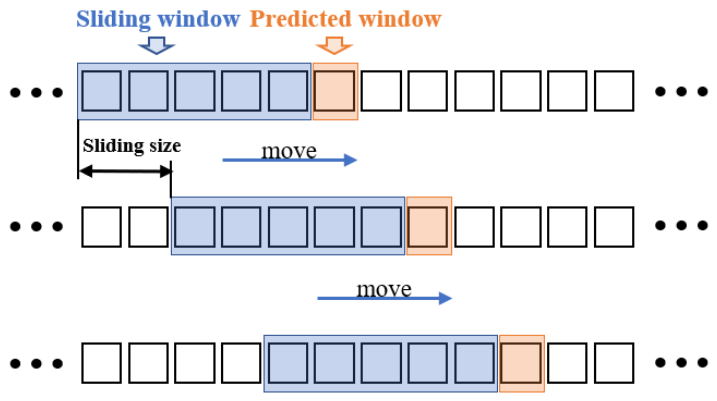
Figure 6. Dividing samples using the sliding window.